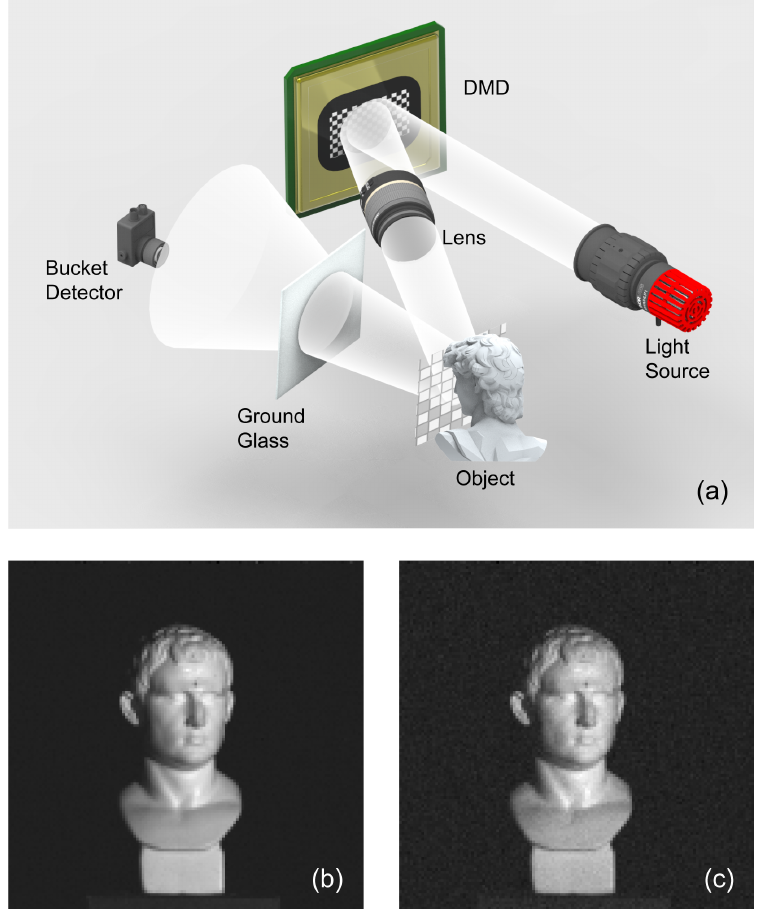
Figure 2. ( a ) Schematic diagram of imaging through scattering media based on SPI. The light source is a white light LED. An amplified photodiode with a 1 inch convex lens is used as the bucket detector. When considering the influence of scattering media on SPI, a sheet of ground glass will be placed in detection part. In all reconstructions throughout this work, imaging resolution is set as 128 × 128 pixels. ( b ) SPI result of object with no scattering medium in the detection part. ( c ) SPI result of object when a sheet of ground glass is placed in the detection part between the object and the bucket